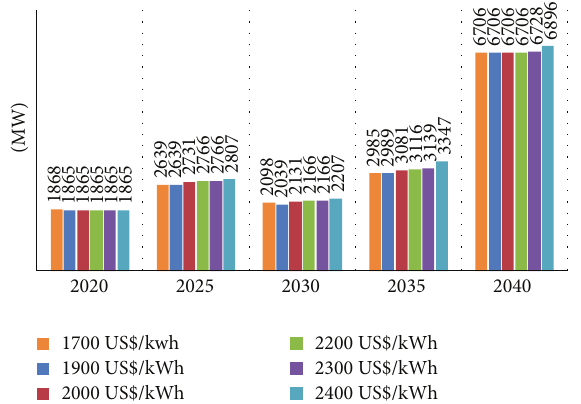
Figure 8: The installed capacity shares changes for CCGT power